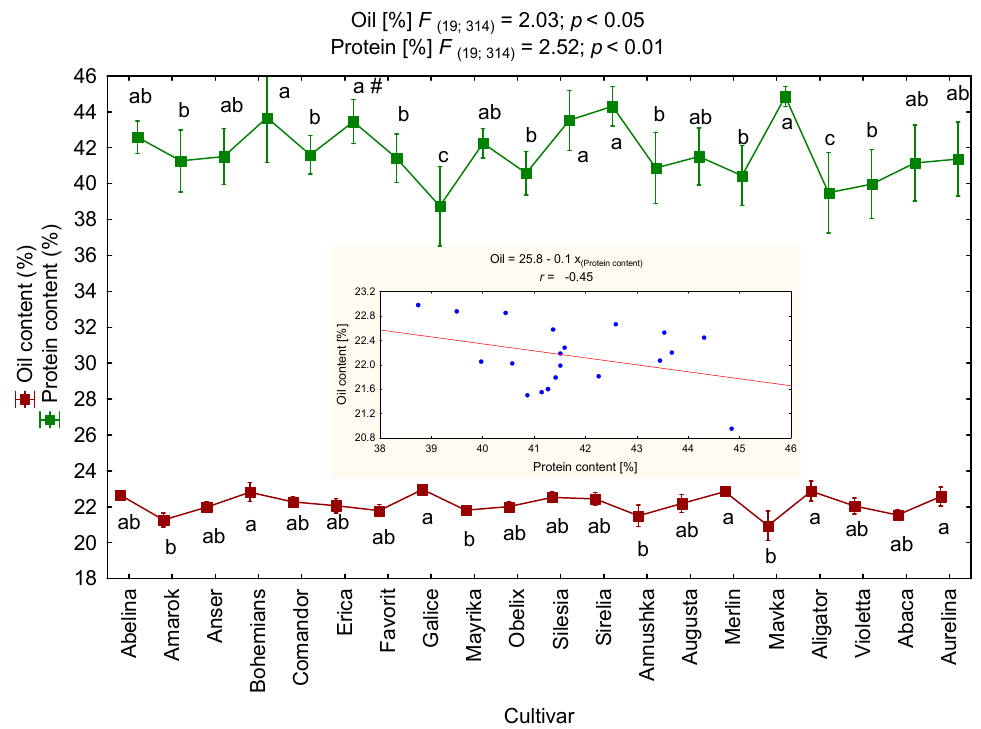
Figure 4. The contents of protein (%) and oil (%) in soybean cultivars and the correlation between protein and oil. Means ± confidence intervals ( p = 0.95) from sites in Central Poland, 2018–2020. # Various letters indicate the heterogenous groups according to the HSD Tukey’s test at p = 0.05.